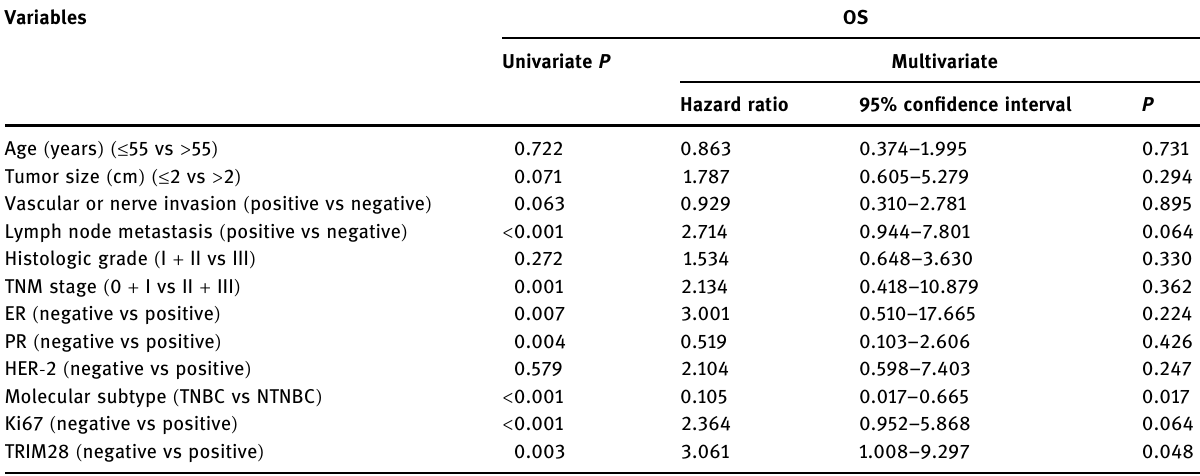
Table 2: Univariate and multivariate Cox regression analysis of overall survival in 114 breast cancer patients